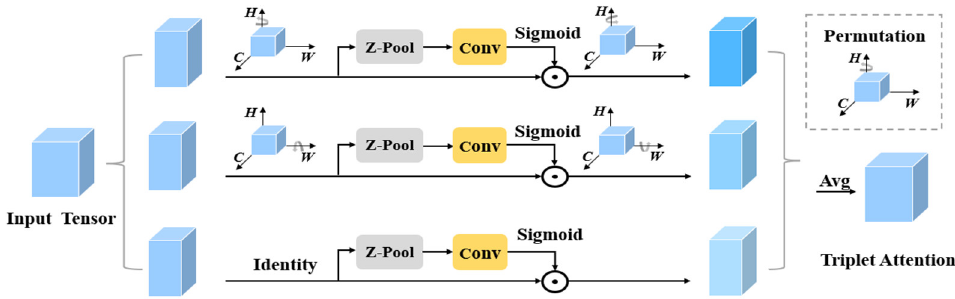
Figure 3. Structure and framework of triplet attention module.